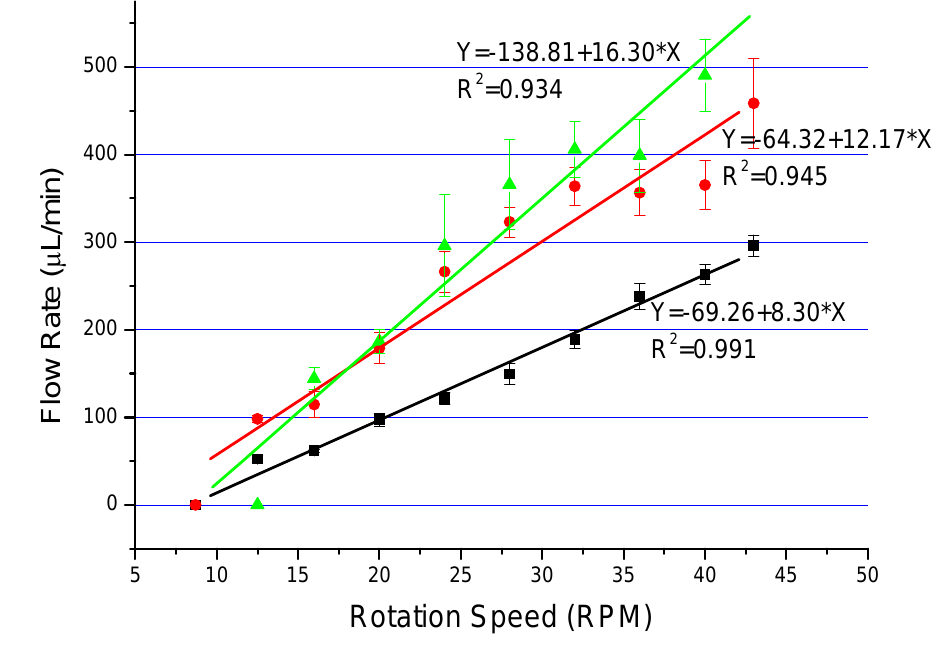
Figure 5. Relationships between flow rate and rotation speed with different (a) ball bearing size; and (b) number of balls at zero back